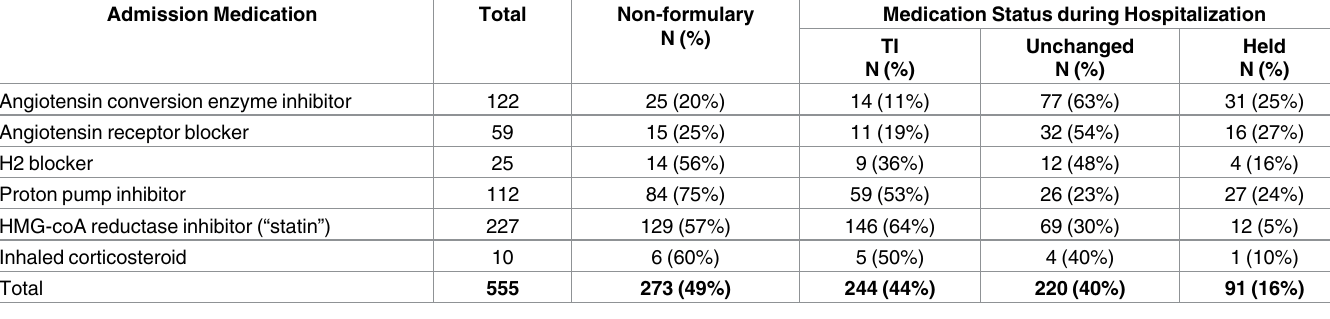
Table 1. Medications of interest characterized by drug class, formulary status and therapeutic interchange. Admission